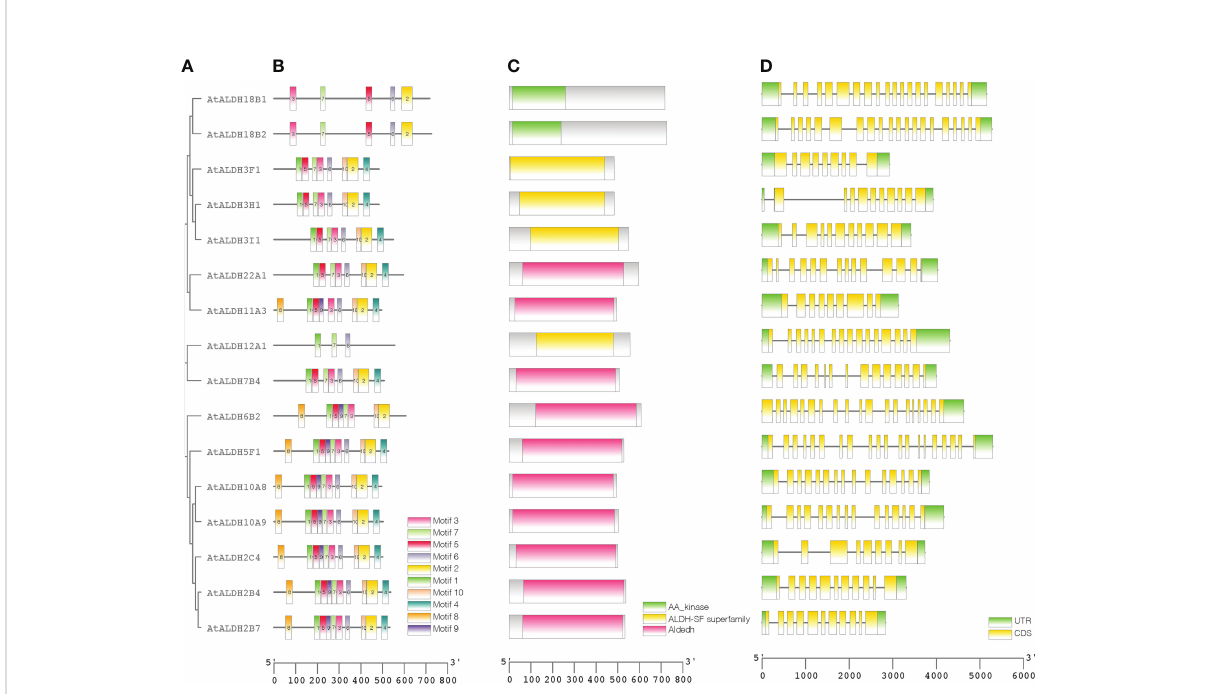
FIGURE 5 Protein sequence and gene structure analysis of ALDHs in Arabidopsis. Phylogenetic relationships, architecture of conserved protein motifs, and gene structure of AtALDH genes. (A) A phylogenetic tree was constructed based on AtALDH protein sequences, MEGA7's Maximum-likelihood method with 1000 bootstrap replicates was used to calculate genetic distances. (B) Motif composition of AtALDH proteins. The motifs, numbers 1-10, are displayed in different colored boxes. (C) Conserved domains of AtALDHs. (D) Exon-intron structure of AtALDH genes. Green boxes indicate untranslated 5 ’ -UTR and 3 ’ -UTR regions; yellow boxes indicate CDS regions; black lines indicate